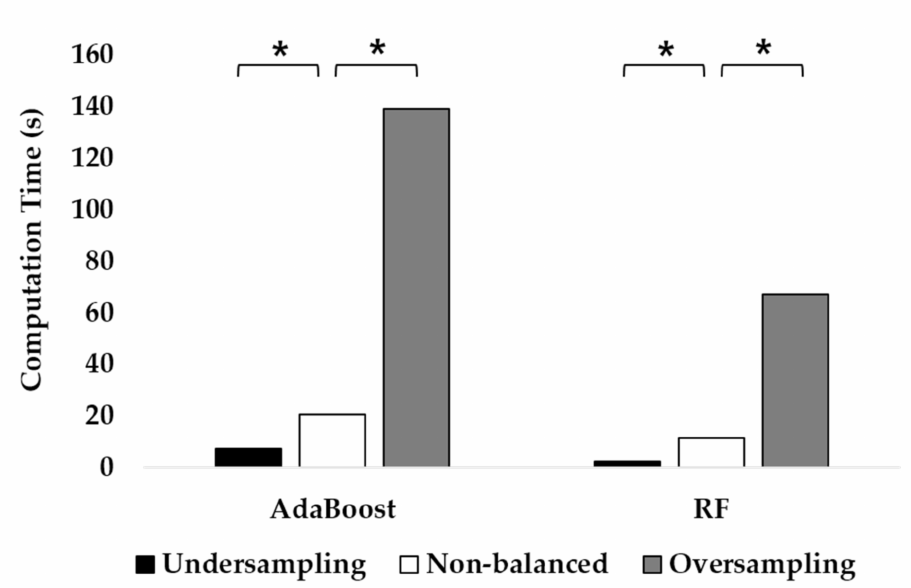
Figure 7. The computational cost of RF and AdaBoost when using the undersampling and oversam- pling approaches. The asterisk (*) denotes p < 0.05 after post hoc